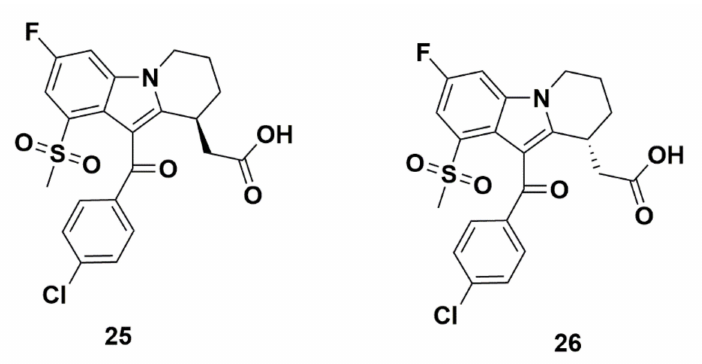
Figure 7. Molecular structures of compounds 25 and 26